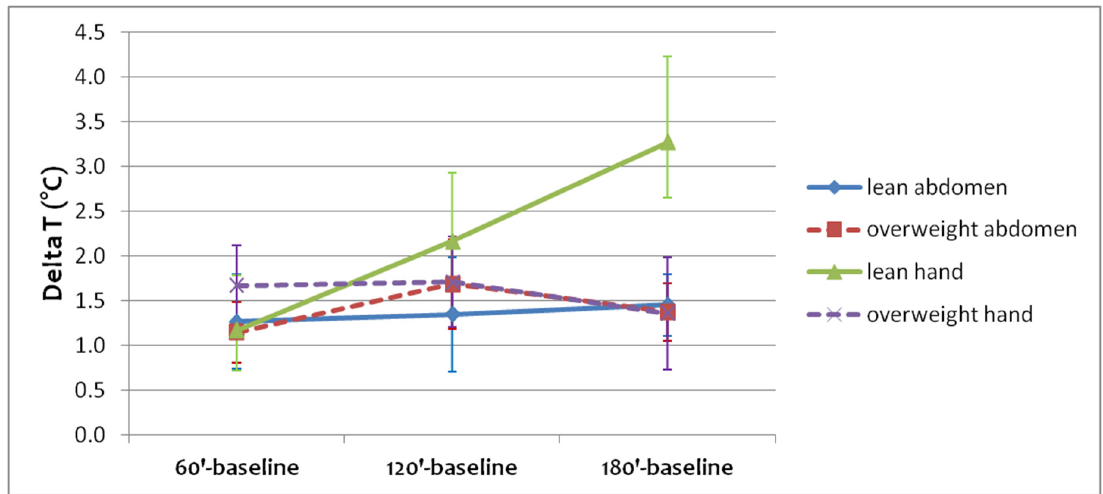
Figure 5. Temperature changes during OGTT with respect to rest (baseline, that is Time 0 ′ ), together with the 95% confidence intervals. For the lean group, both abdominal and hand temperature continues to increase, while for the overweight group abdominal and hand temperature increases only during the first two hours of OGTT.